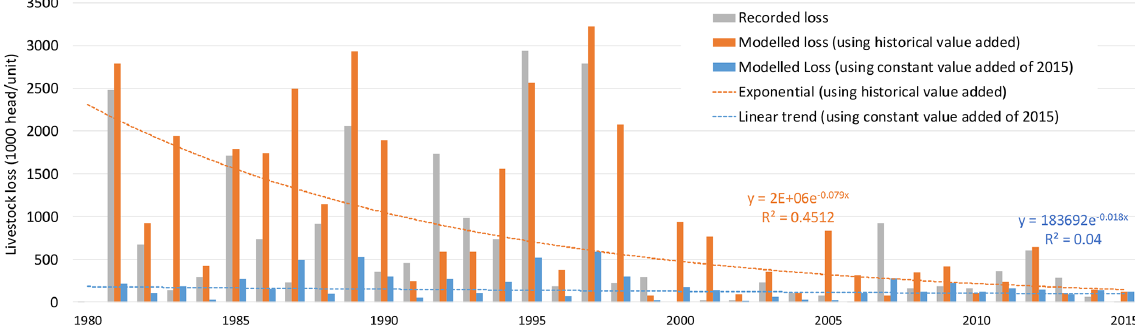
Figure 6. Model-derived annual livestock loss from snow disasters in the QTP (1980–2015). The unit of modelled loss has been converted from sheep units to heads (units) by them dividing by 2.2 (total sheep units ≈ 2 . 2 × herd size by heads (units) according to the cattle : sheep structure in the QTP). Recorded losses during 1980–2000 were collected from Wen (2008) and during 2003–2016 were from China meteoro- logical administration. The exact figures may differ from other sources (i.e. Wei et al., 2017) as only the losses of major events were included in our data